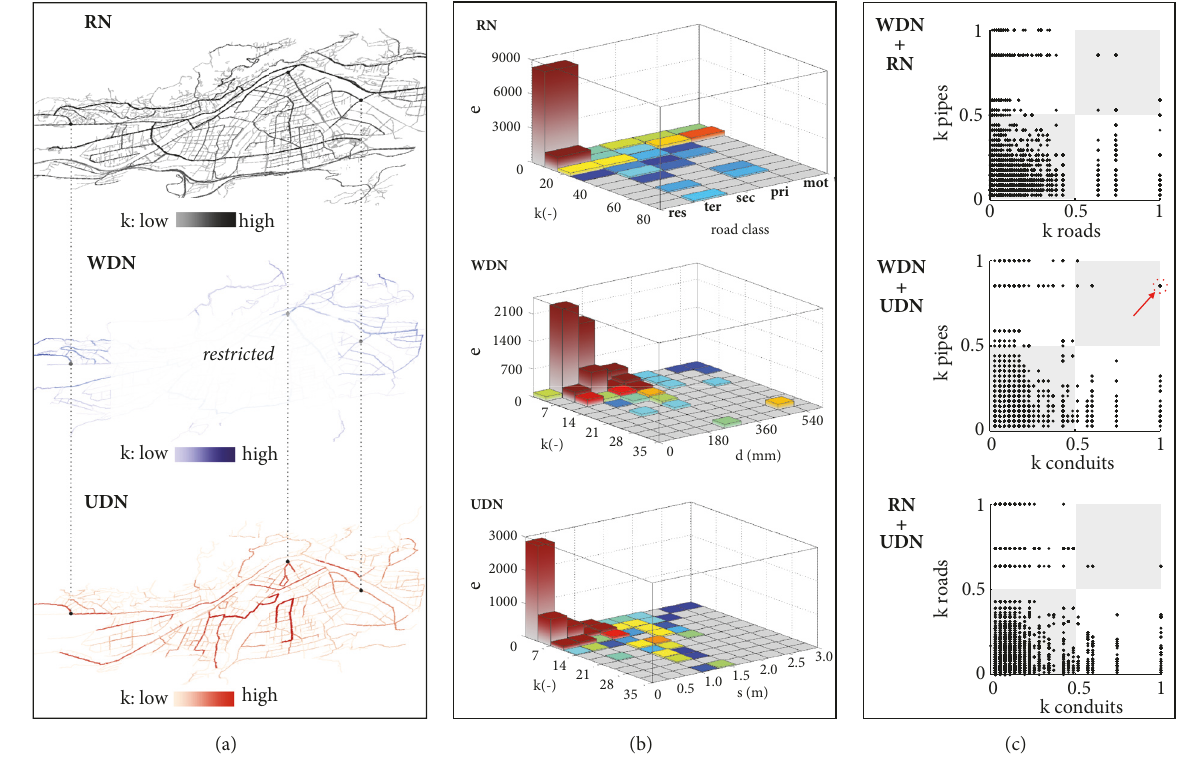
Figure 8: Remapping of the dual (node) degree to the primal space for WDN, UDN, and RN. (a) Remapped dual degree; (b) correlation analysis between dual degree and functionaledge classdescribing flow capacity: 𝑒 is thenumberof primal edges and the road classesrepresent residential ( res ), tertiary ( ter ), secondary ( sec ), and primary ( pri ) roads and motorways ( mot ); and (c) co-location of dual degree among different network